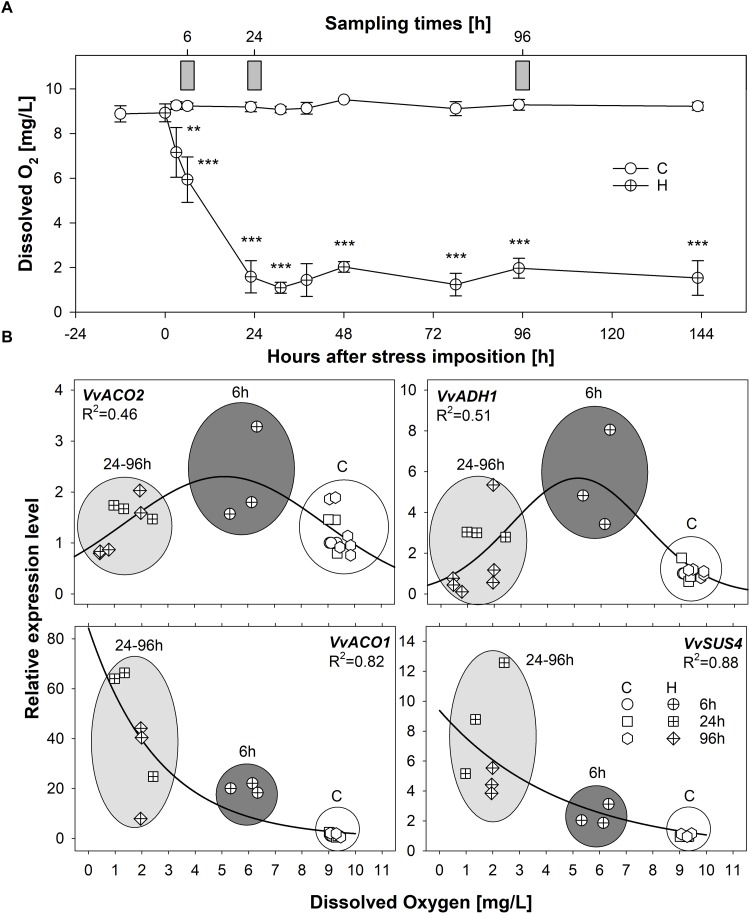
(A) Levels of dissolved oxygen (mg/L) in hydroponic solution, measured in the vicinity of roots during a time-course experiment of 6 days in 5 L beakers constantly oxygenated (control plants; empty circles) or not oxygenated and isolated from oxygen (plants exposed to hypoxia; crossed circles); values represent mean ± SE and asterisks denote mean values that are statistically different at ∗∗p < 0.01, ∗∗∗p < 0.005; gray bars indicate sampling points for gene expression analyses of hypoxia-responsive marker genes shown in panel B. (B) Scatter plot of the expression of the candidate hypoxia-responsive markers VvACO1 and VvACO2, VvADH1 and VvSuS4 plotted against levels of dissolved oxygen in hydroponic solution under well oxygeneted (empty symbols) and progressive hypoxic conditions (crossed symbols). Gray-shaded ellipses/circles indicate the expression levels measured at 6 h (dark gray) and 24–96 h /light gray); indicate the expression levels measured at successive time-points; white circles group the expression levels measured in roots of control plants at all time-points. Solid lines indicate three-parameter Gaussian and hyperbola decay best fit curves for (VvACO2, VvADH1) and (VvACO1, VvSuS4), respectively. Supplementary Figure S2 enables the statistical identification of significant differences among the samples under the different Control and Flooded treatments.